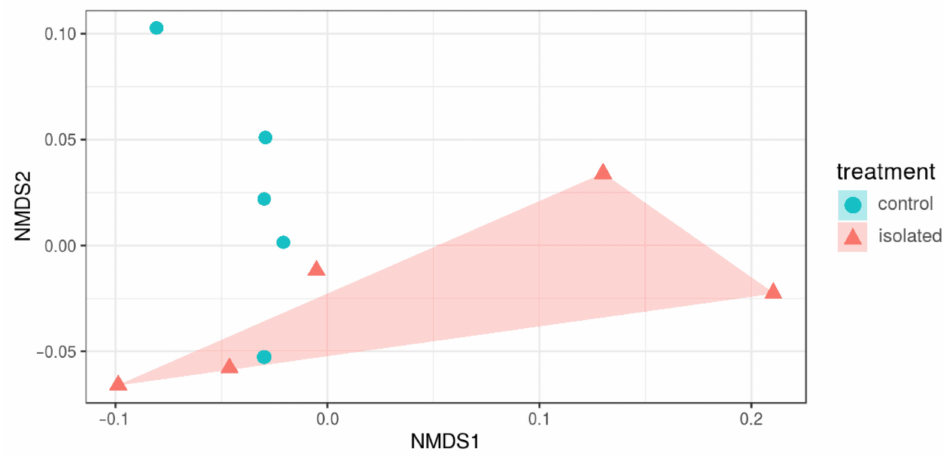
Figure 3. Bray–Curtis dissimilarity matrix between the 10 sheep handled under different husbandry conditions. First two dimensions from the (non-metric) multi-dimensional scaling (NMSD1 and NMSD2) of the Bray–Curtis dissimilarity matrix. Samples were grouped by experimental unit (treatment: isolated;